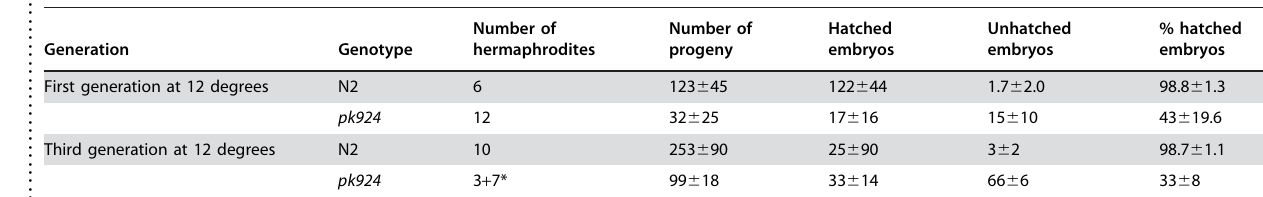
* Seven hermaphrodites were sterile. Averages are for the three fertile hermaphrodites. doi:10.1371/journal.pone.0001213.t002 .